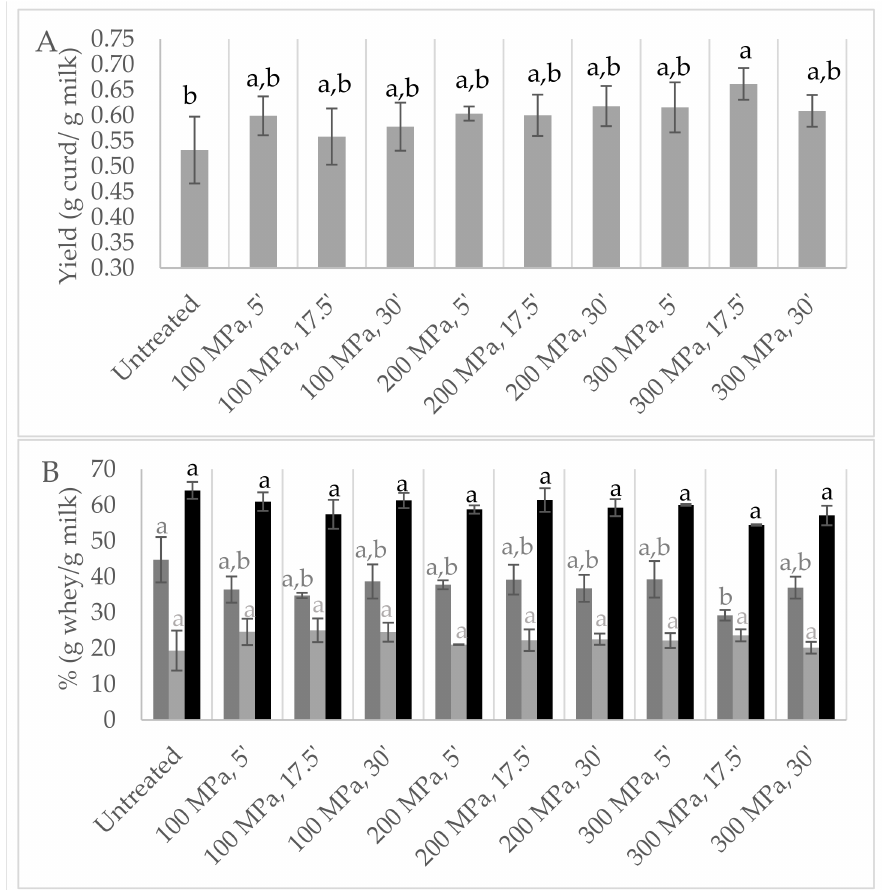
Figure 5. Design of experiment results: ( A ) yield expressed in g of curd per g of milk; ( B ) whey release immediately after centrifugation: first whey ( (cid:4) ); syneresis (24 h) ( (cid:4) ); whey + syneresis ( (cid:4) ); from milk high-pressure processing (HPP)-treated according to central composite design. Control samples are untreated milk. Different non-capital letters (a, b) indicate statistically significant differences between the different conditions ( p <